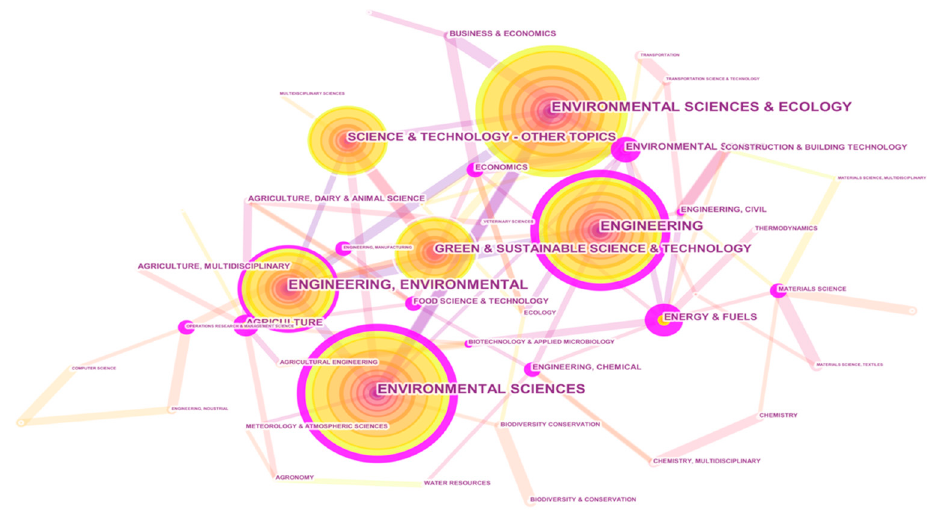
Figure 4. Disciplines shown as a minimum spanning tree network of subject categories.